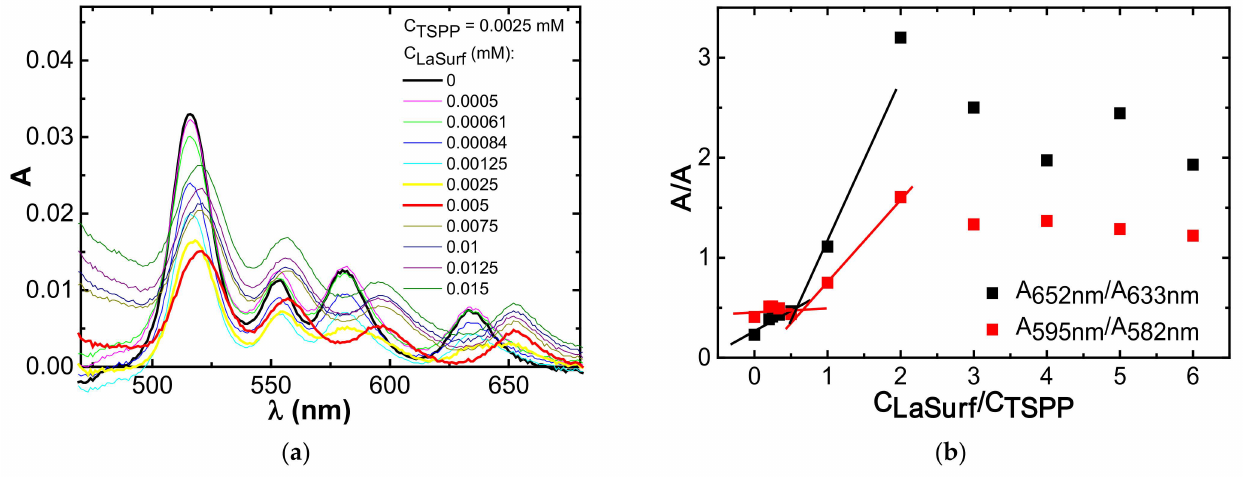
Figure 3. ( a ) Q band region of the absorption spectra of TSPP in the absence and presence of various amounts of LaSurf; ( b ) corresponding dependences of the ratio of absorption intensities (A 595 nm /A 582 nm , A 652nm /A 633nm ) on the ratio of LaSurf amount in a mixture with TSPP (H 2 O, 25 ◦ C, 1 cm